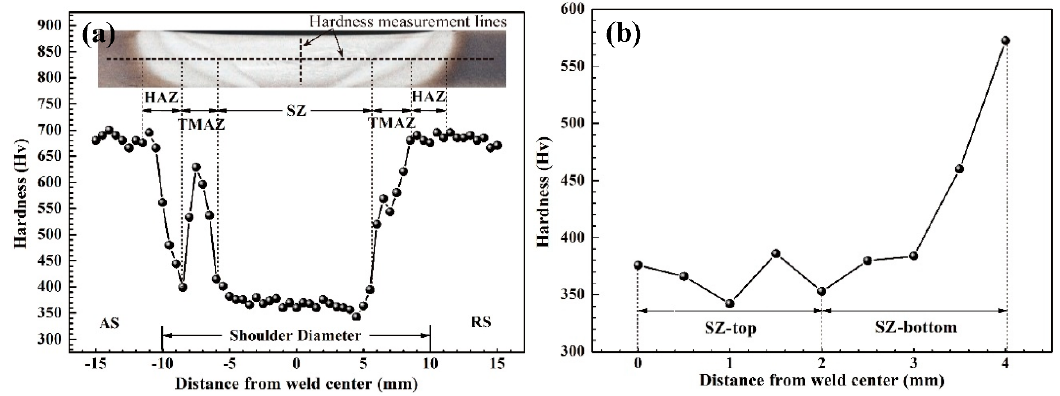
Figure 10. Micro-hardness distributions of joint through ( a ) horizontal and ( b ) vertical directions.